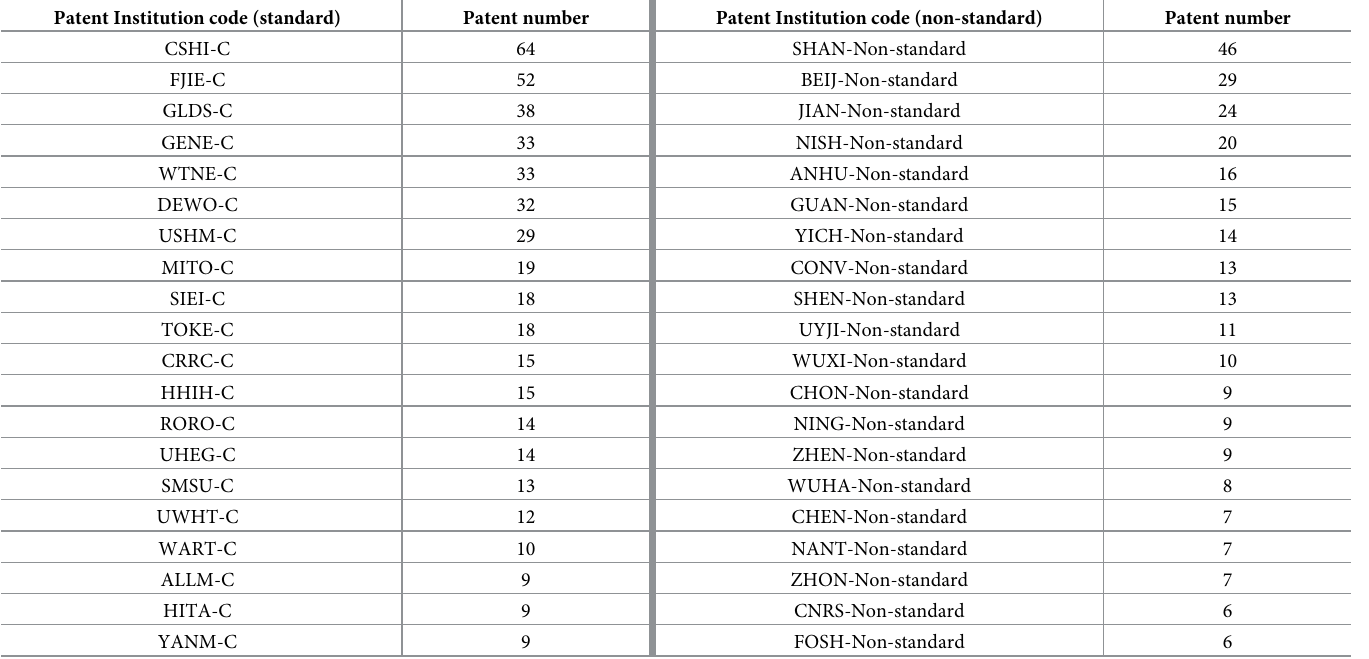
Table 1. The number of corporate patents (Top